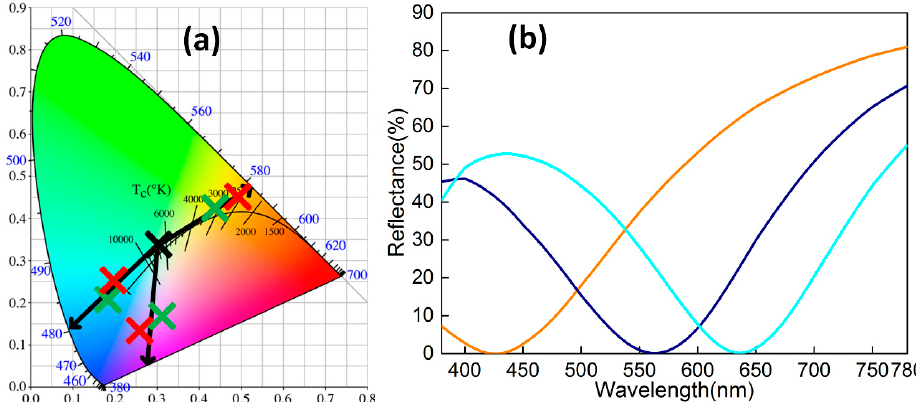
Figure 3. ( a ) The simulated (green crosses) and measured (red crosses) CCs with similar color features in chromaticity diagram. ( b ) The experiments measured a reflection spectrum for the 380–780 nm range for d ZnS = 20, 40, and 60